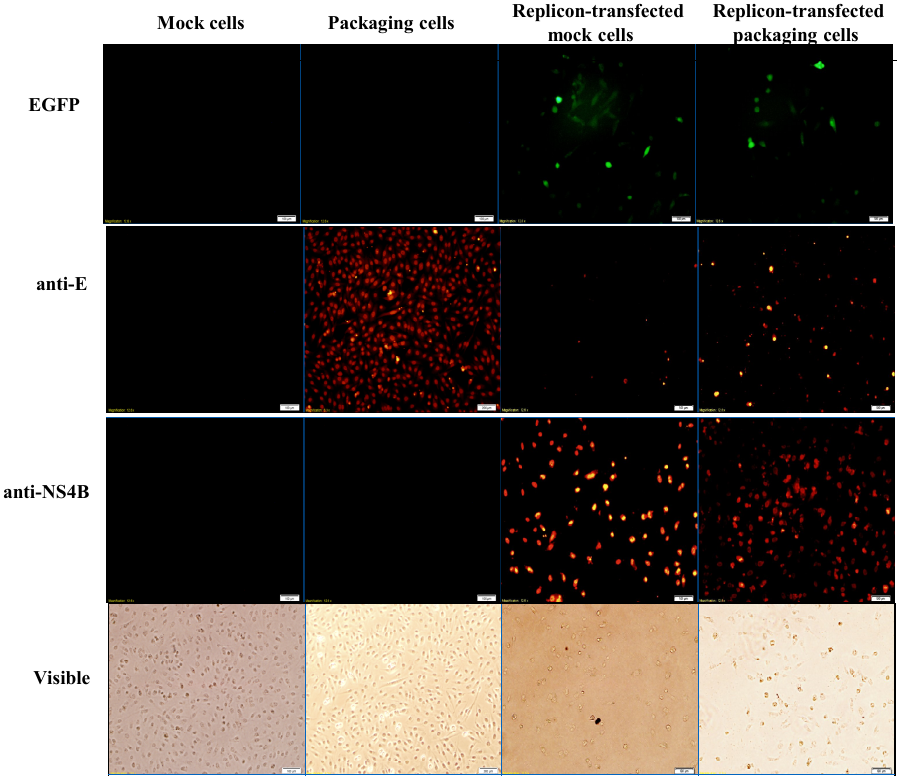
Figure 4. Analysis of the expression of EGFP and JEV in mock cells, packaging cells, replicon ‐ transfected mock cells and replicon ‐ transfected packaging cells using immunofluorescent staining. The cells were washed, fixed, and reacted with indicated primary antibodies and Alexa Fluor 546 ‐ conjugated secondary antibodies (ThermoFisher, Waltham, MA, USA). Finally, imaging of cells was taken by immunofluorescent microscopy. In addition, the cell morphology was photographed using bright ‐ field microscopy.